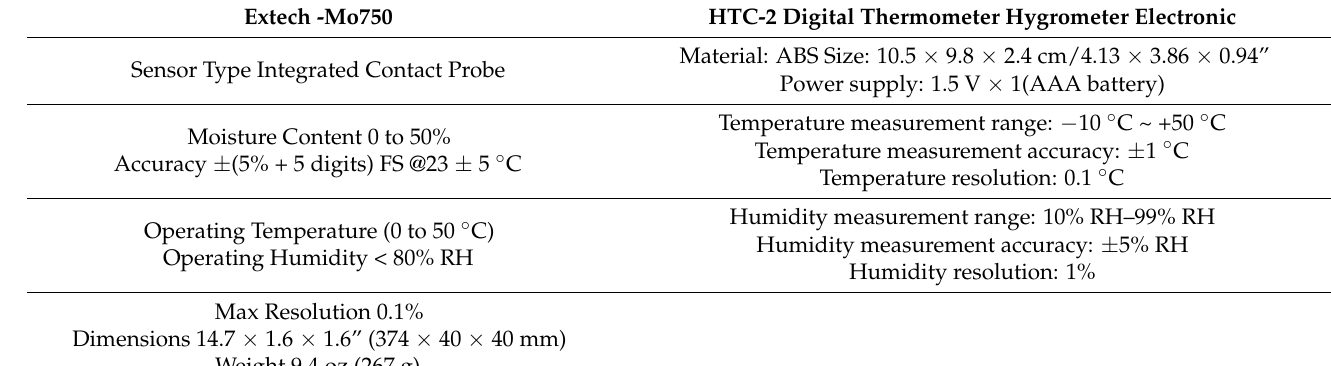
Table 2. Specifications and range of the HTC-2 Digital Thermometer Hygrometer Electronic and Extech